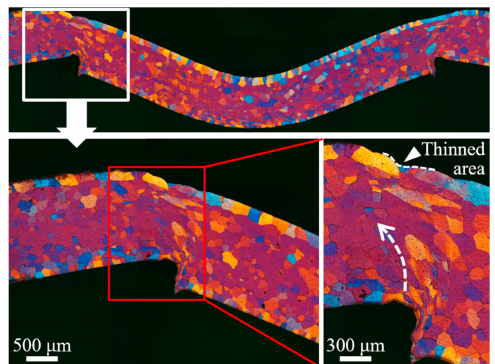
Figure 13. Microscopic pictures of position D under 16 kJ.